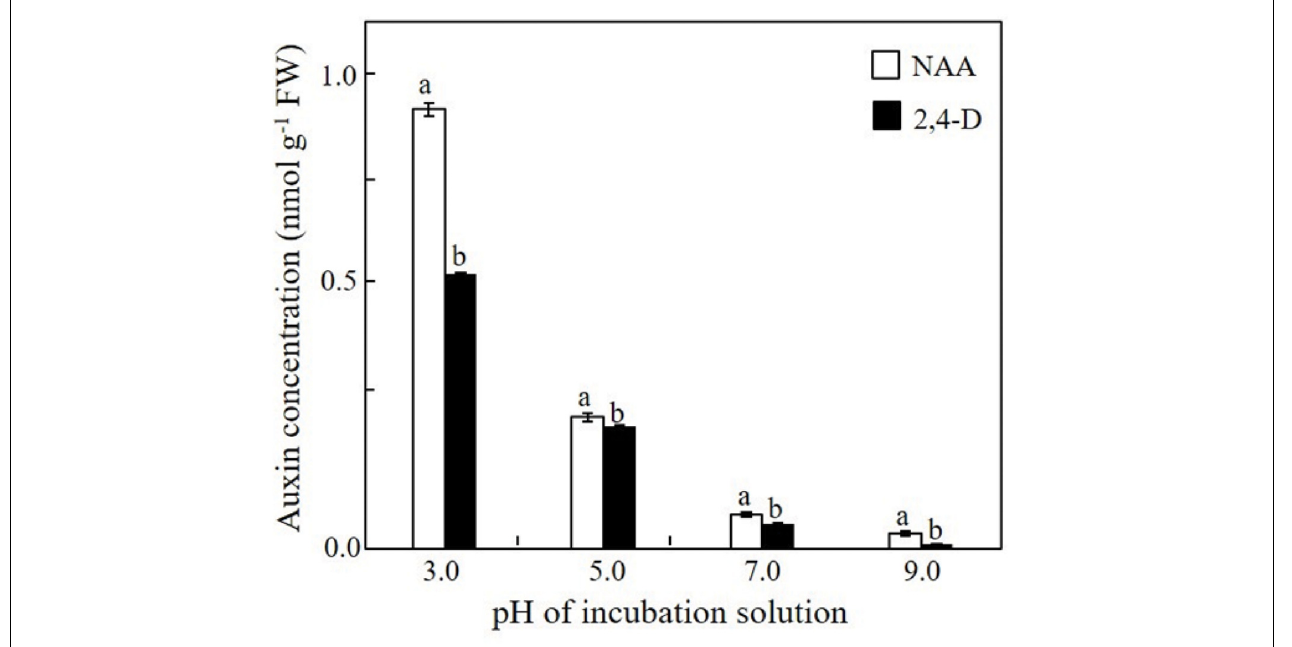
FIGURE 4 | Effect of the pH of the incubation solution on the uptake/adsorption of NAA or 2,4-D by the xylem shoot sections excised from Red Cestrum cut flowers. Samples of 2- to 3-mm-long sections of xylem tissue were incubated for 1 h in 0.2 mM NAA or 2,4-D containing radiolabeled standards at the indicated pH. The extracted radiolabeled auxins served for determination of the auxin concentration in the treated xylem sections. Each value represents means of three replicates ± SE. Different letters indicate significant differences between treatments at each pH separately, at P ≤ 0.01 according to the Tukey–Kramer HSD test using one-way